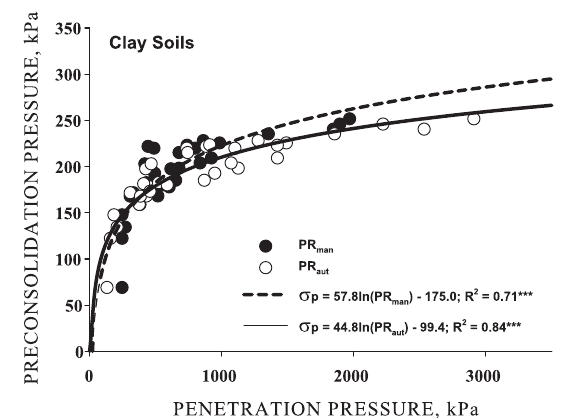
Figure 8. Relation between preconsolidation pressure and penetration resistance for clayey soils.